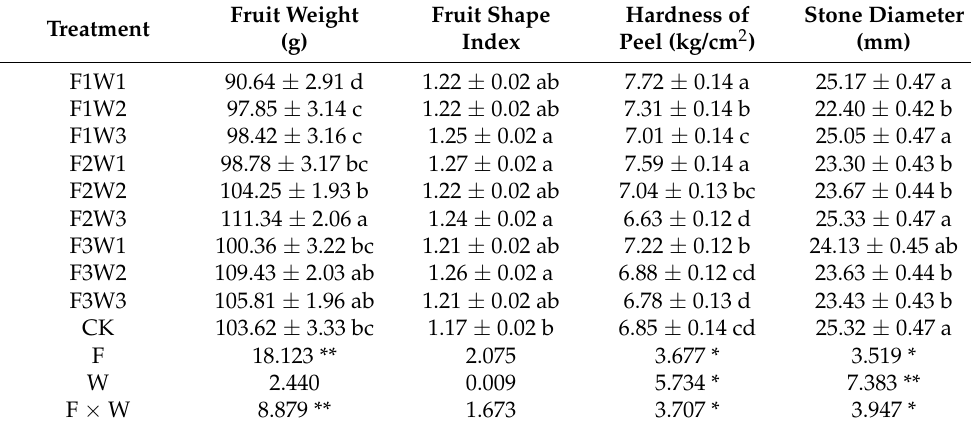
Table 6. Changes (mean ± standard error) in physical properties of fragrant pear under different methods and volumes of irrigation.